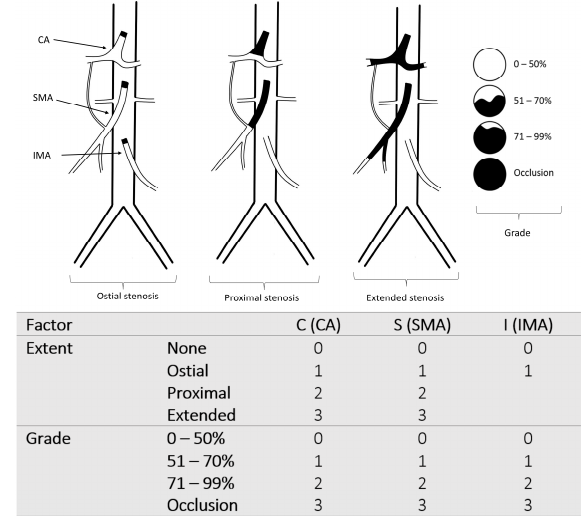
Figure 2. Classification and scoring model of the stenosis of the main visceral arteries. CA: celiac artery, SMA: superior mesenteric artery, IMA: inferior mesenteric artery. The grade of stenosis was measured in terms of the residual lumen’s diameter (D stenosis) and the estimated normal luminal diameter at the level of the stenosis (D normal) [5]. Therefore, the percentage of stenosis was calculated as (1 − D stenosis/D normal) × 100 (see Figure 3). In the case of generalized calcification of the artery, we estimated the degree of stenosis in terms of the narrowest diameter. This classification describes the lesions in a normal anatomical pattern, representing about 75% of the population [6,7]. However, in most cases, the absence of one of the vis- ceral arteries and other anatomical variations could be considered in this classification.